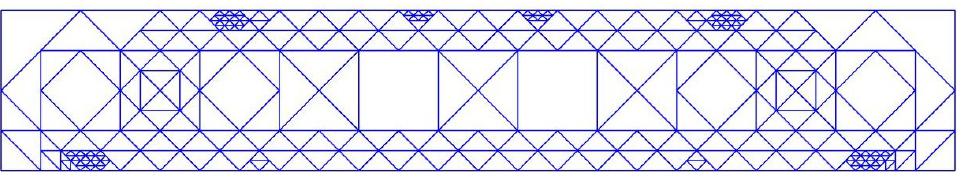
Figure 10. Final part with optimised infill using refinement technique with threshold stress = 25 MPa and minimum length of a side of the infill design (L) ≥ 2.4 mm as stopping criteria (infill density = 22%).